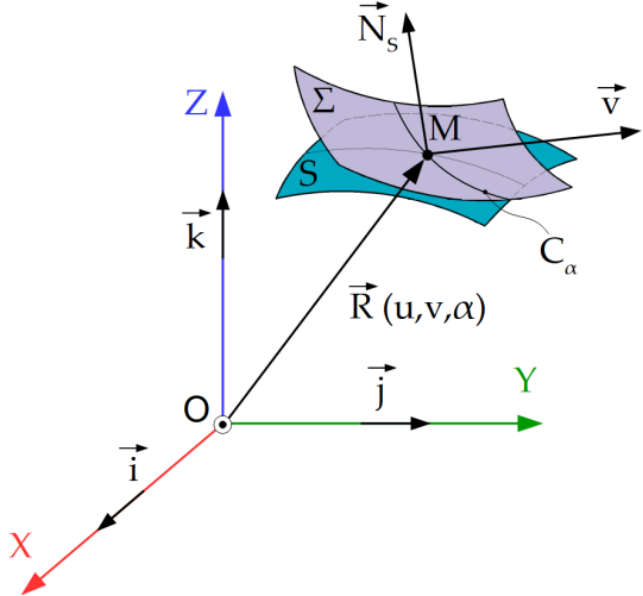
Figure 1. Characteristic curve.